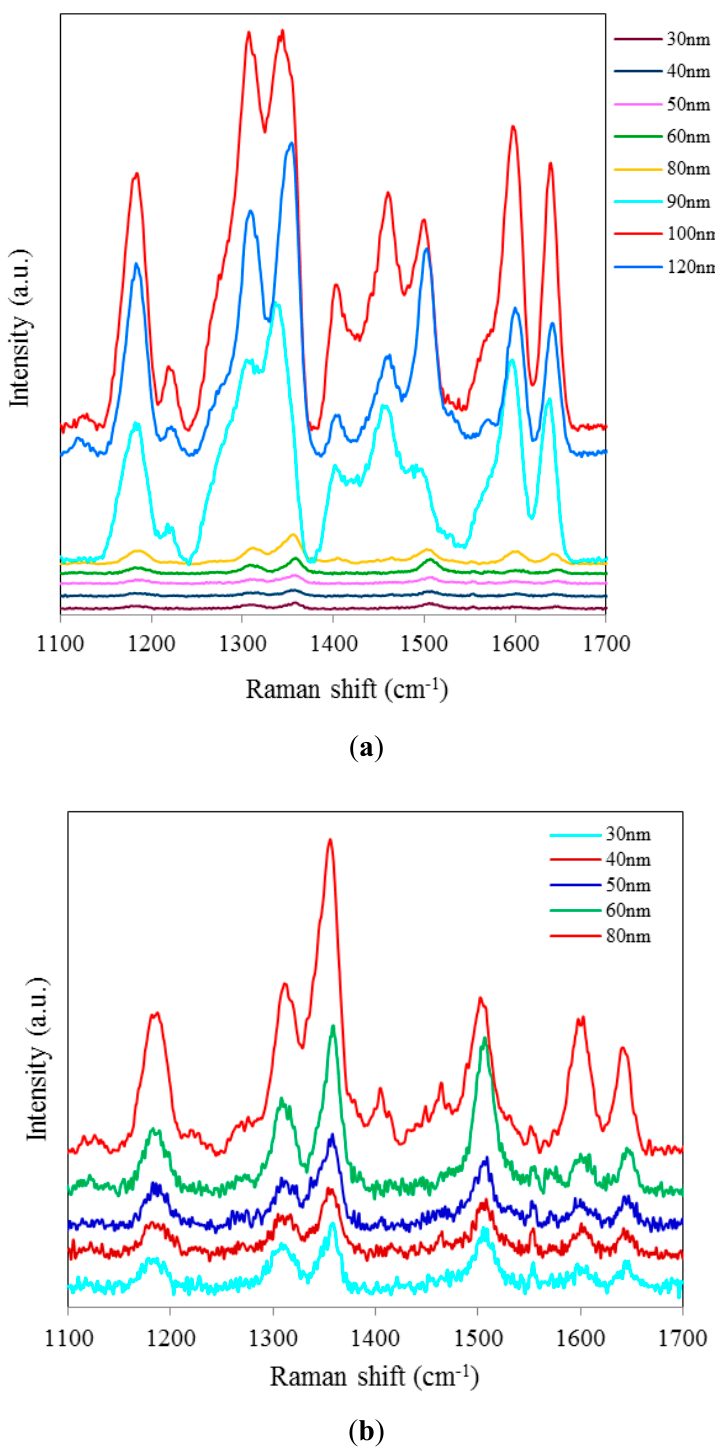
Figure 5. SERS spectra of 8 × 10 − 5 M solution of Rh6G dye adsorbed on the surface of 80 nm NAAO nanoporous substrate coated with 30, 40, 50, 60, 70, 80, 90, 100, 120 nm gold films measured with 3 s integration time ( a ); Figure ( b ) shows the relative enhancement of the weak Raman signals after removing the spectra for the 90, 100, and 120 nm gold coated 80 nm pore size substrate measured with 3 s integration time.